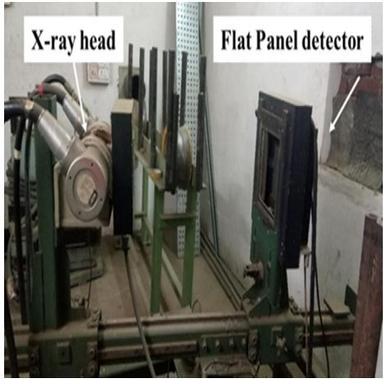
Snap-shot of the Digital Radiography system used for FWTPET inspection.